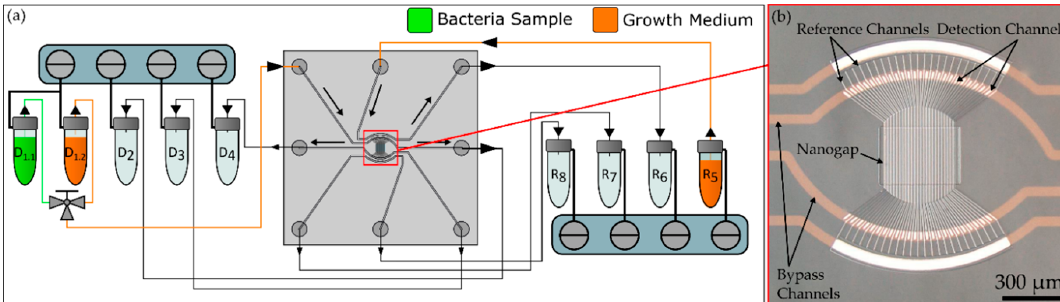
Figure 2. ( a ) Schematic of the fluidic setup with eight pressure controllers and sample reservoirs for the detection channels ( D 1.1 to D 4 ) and reference channels (R 5 to R 8 ) connected to the nanograting chip and a three way valve to switch between capture and growth mode. ( b ) Microscopic top view image